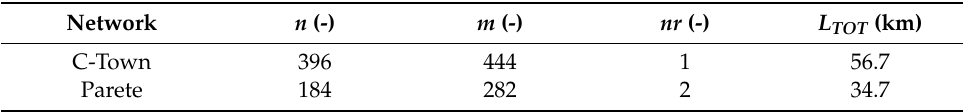
Table 3. Main characteristics of water distribution network of C-Town and Parete. The symbol in brackets “-” indicates that the parameter is